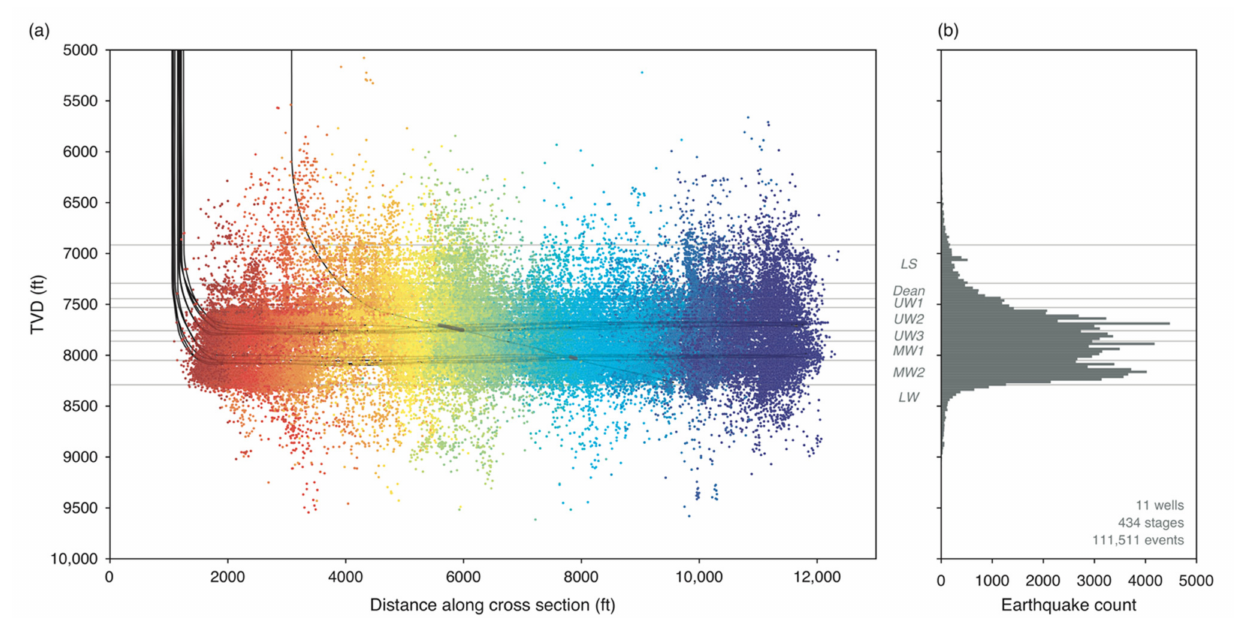
Figure 3. ( a ) N-S cross section of microseismic events generated by hydraulically fracturing horizontal wells in the Upper and Middle Wolfcamp. Events are colored by the stage where they were generated. Each well has between 37–49 stages. ( b ) Histogram of event depths from all